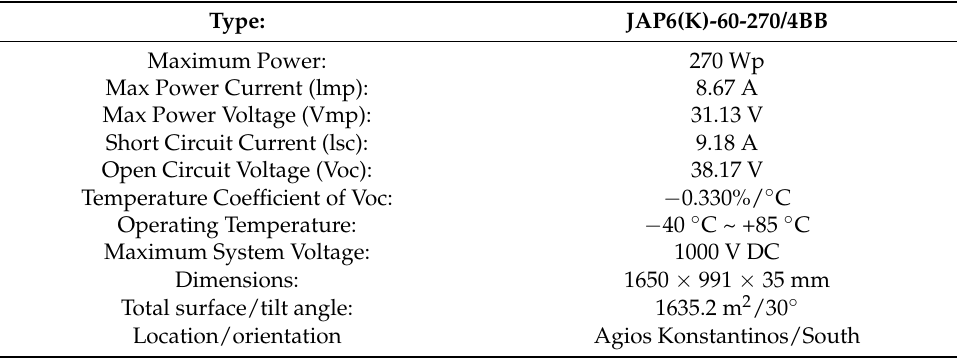
Figure 16. Photo of the Tilos HPS PV plant, installed at the central part of the island. Table 2. Main characteristics of installed PV park. Table 2. Main characteristics of installed PV